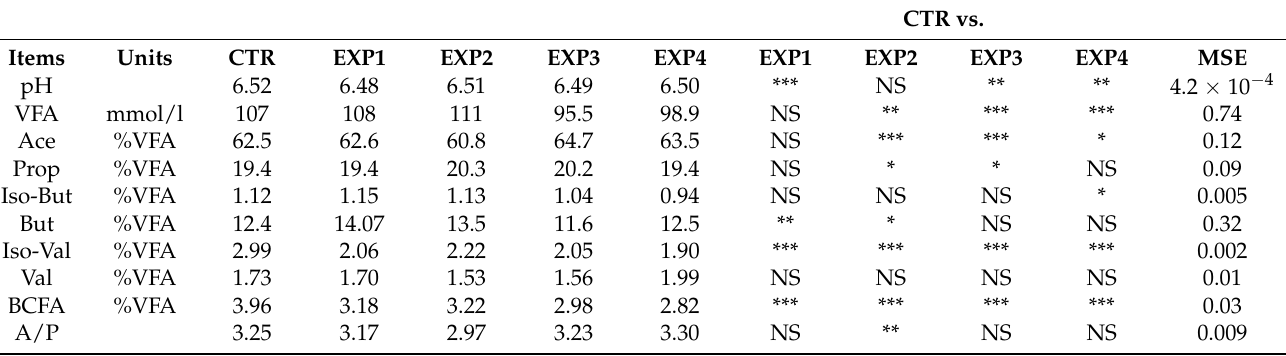
Table 7. In vitro fermentation end-products: control vs. experimental diets with buffalo inoculum .